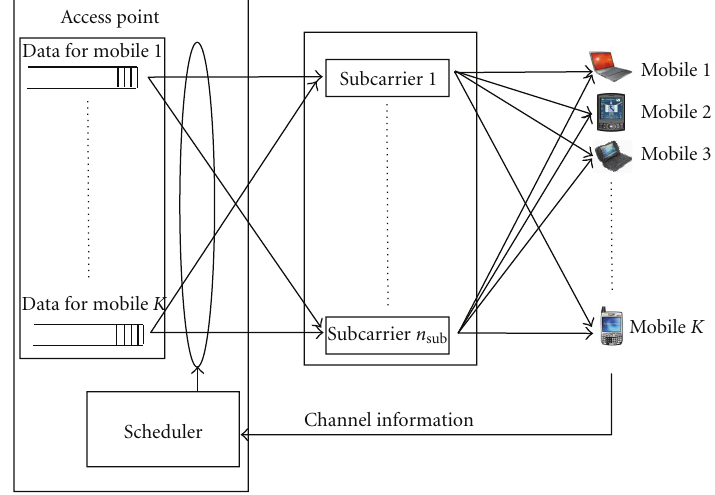
Figure 2: Opportunistic allocation of the radio resources among the set of mobiles in the